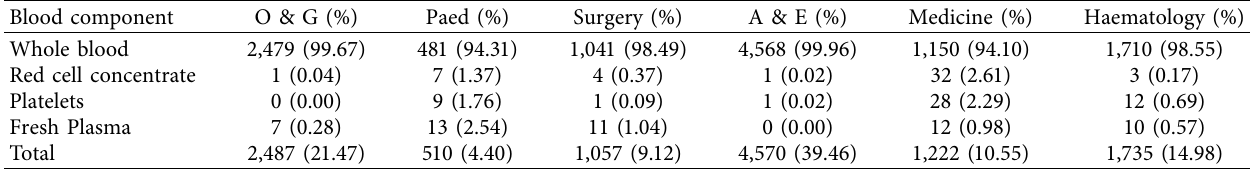
Table 6: Pattern of usage of blood and blood components across clinical